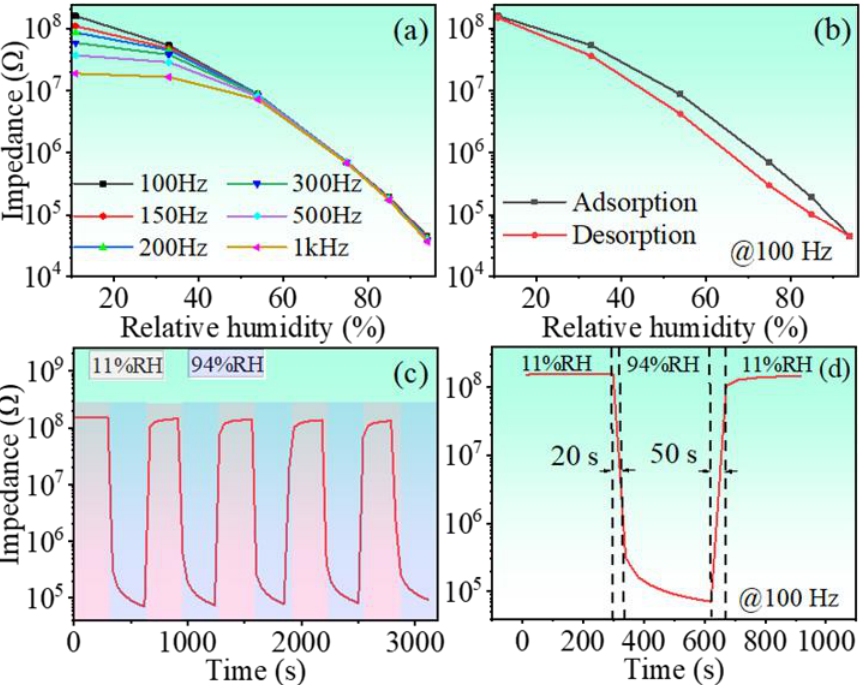
Figure 8. ( a ) Impedance as function of RH level, ( b ) humidity hysteresis curve, ( c ) repeatability curve, and ( d ) response/recovery curve of the HINO-0.005.